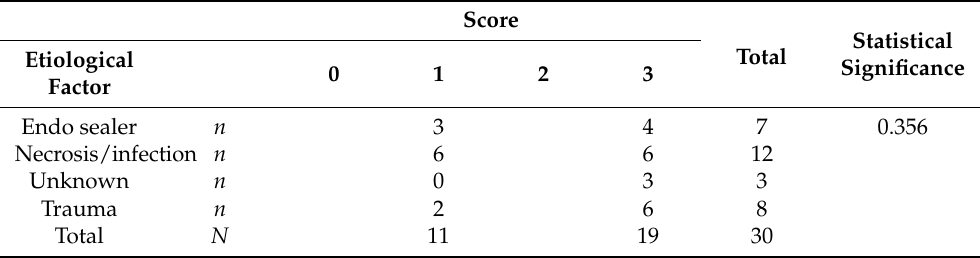
Table 2. Bleaching success depending on etiological factors.